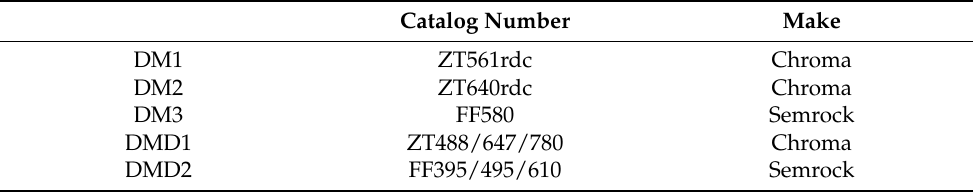
Table 1. Information of dichroic